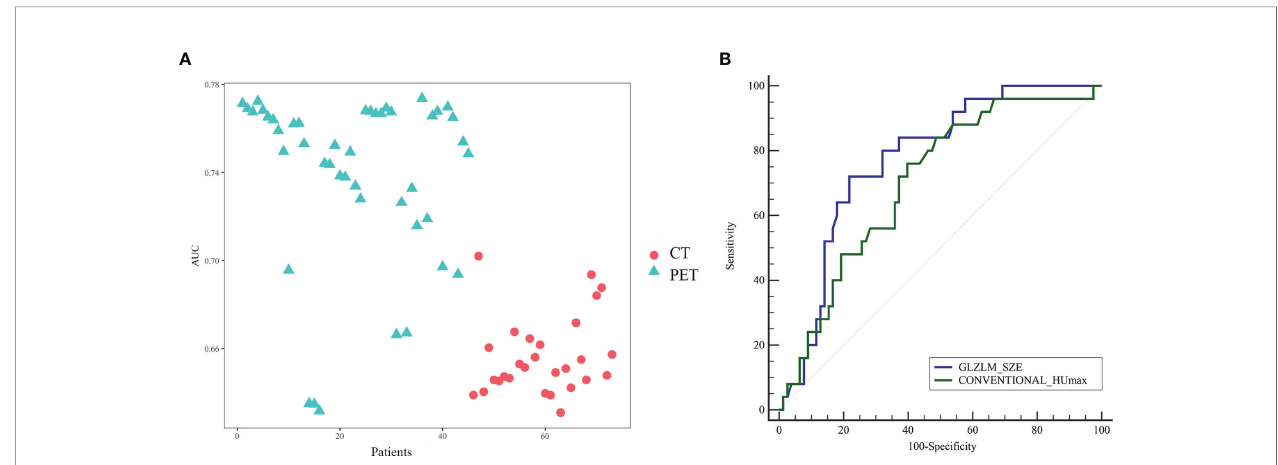
FIGURE 1 | (A) The performance of radiomic features for the evaluation of tumor microenvironment immune type (TMIT)-I tumors. All the features showed moderate power for predicting the TMIT-I tumors, and PET features have better ability than CT features with higher area under the receiver operating characteristic (ROC) curve (AUC). Panel (B) was the ROC curve of the optimal PET (GLZLM_SZE) and CT (Conventional_HUmax) features to distinguish TMIT-I from other groups.